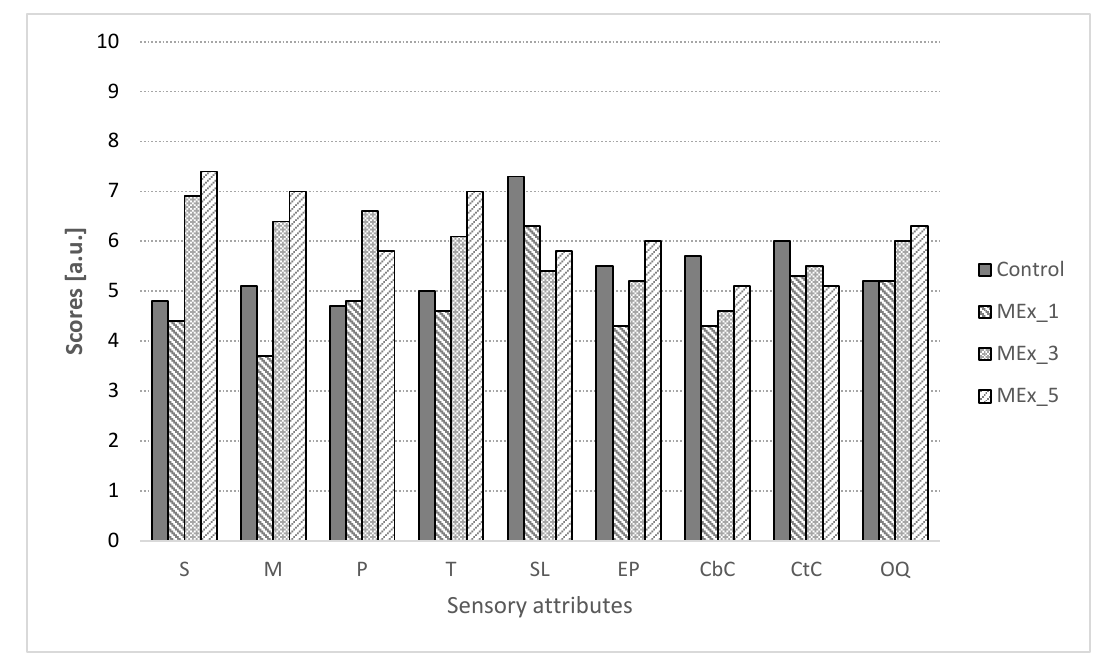
Figure 3. Scores of consumer acceptance analysis of muffins with dry Mex. MEx_1, MEx_3, and MEx_5—samples with 1, 3, and 5% replacement of flour on dry marigold extract, respectively. S—softness, M—moisture, P—porosity, T—taste, SL—smell, EP—extract’s perceptibility, CbC—crumb color, CtC—crust color, OQ—overall quality.